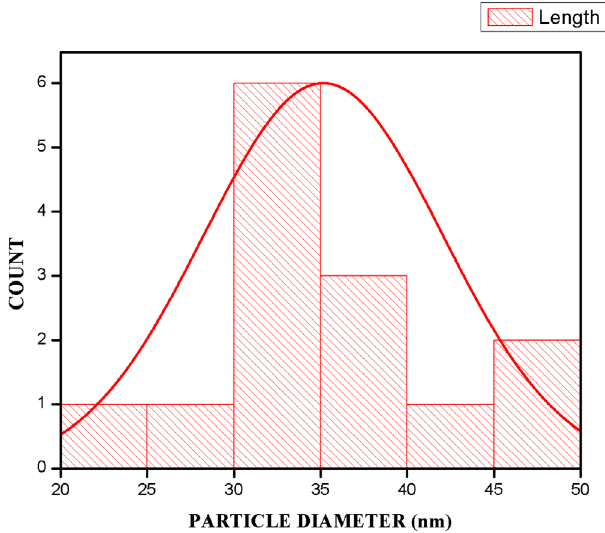
Figure 3. Histogram plot of the obtained TEM